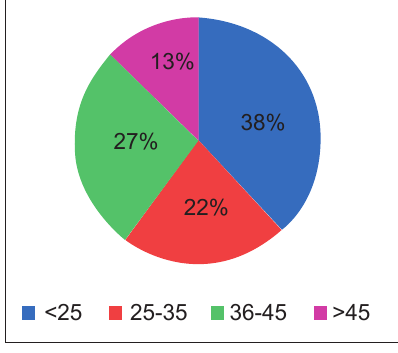
Figure 3: Age distribution of respondents